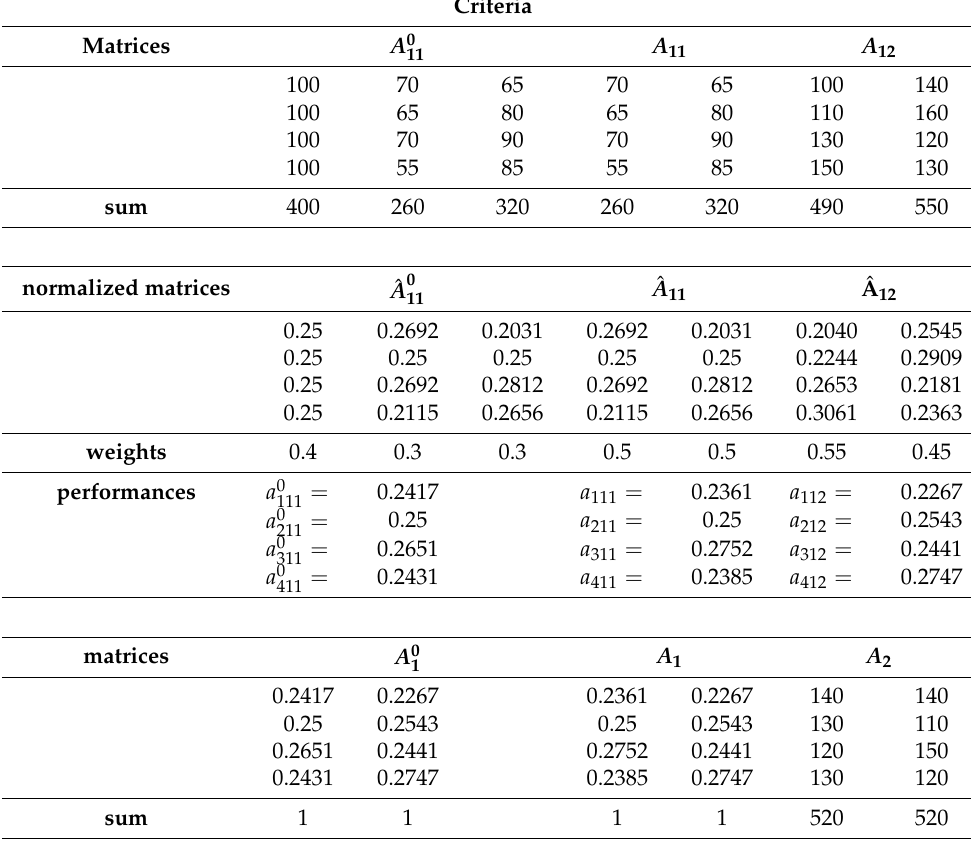
Table A4. Summary of Example 2 solution under L 2